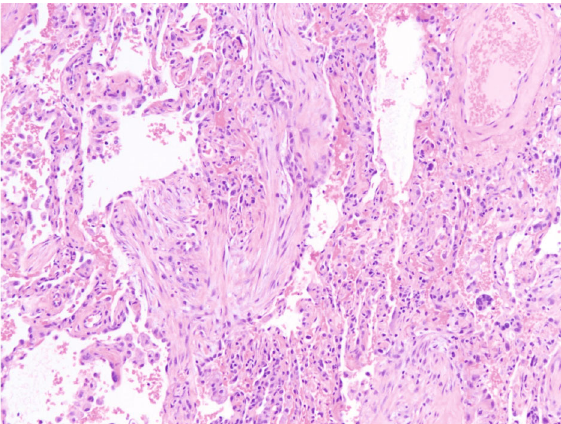
Figure 3: Surgical biopsy obtained from right lung. Pathology with hematoxylin-eosin stain at 200 × magni fi cation shows organizing pneumonia in a background of di ff use alveolar